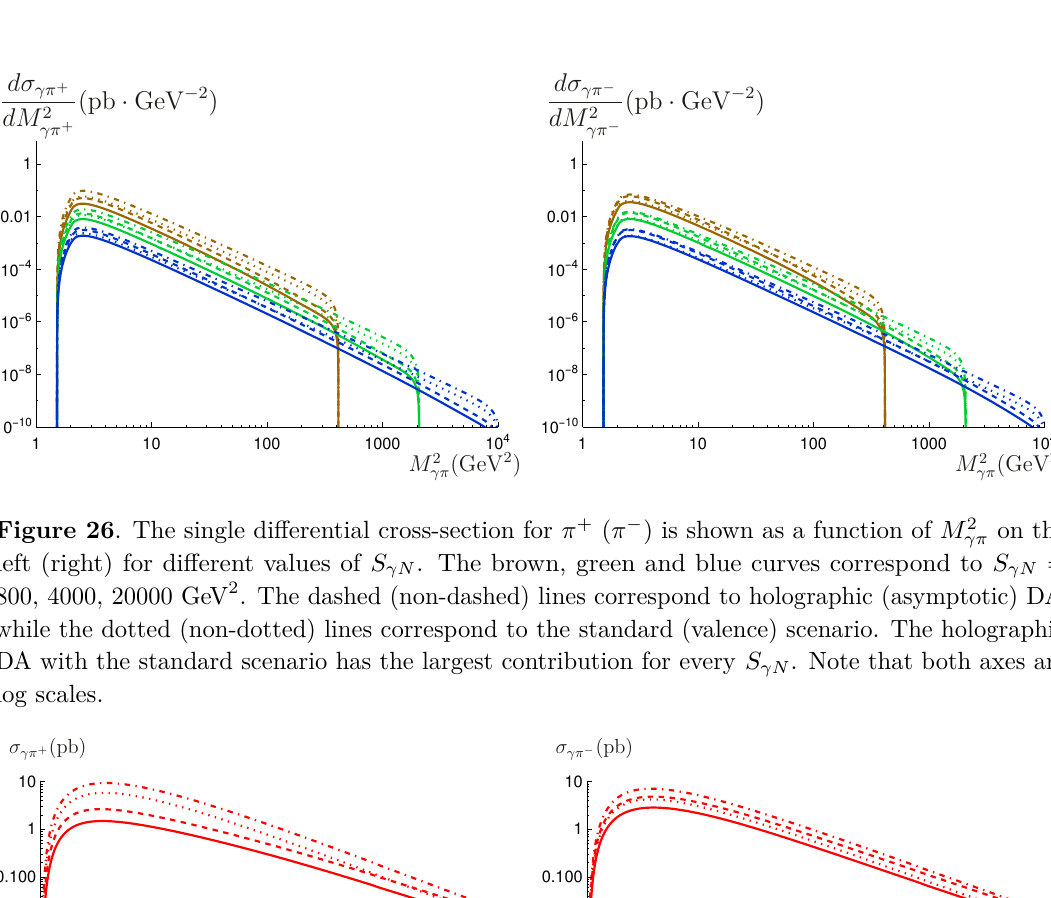
Figure 27 . The integrated cross-section for π + ( π − ) is shown as a function of S γN on the left (right). The dashed (non-dashed) lines correspond to holographic (asymptotic) DA, while the dotted (non-dotted) lines correspond to the standard (valence)